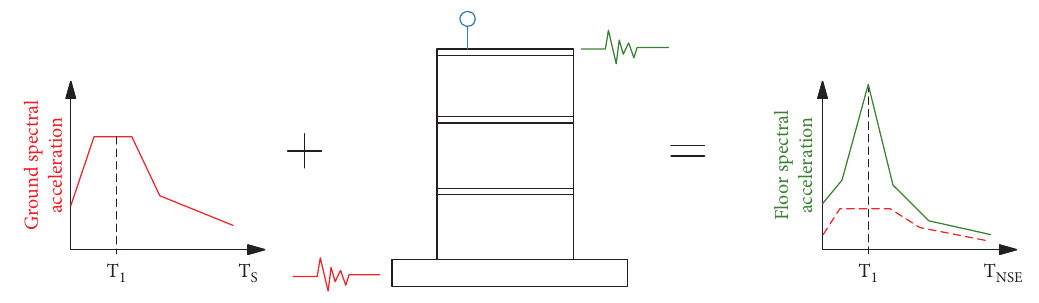
Figure 4: Ground response spectrum and